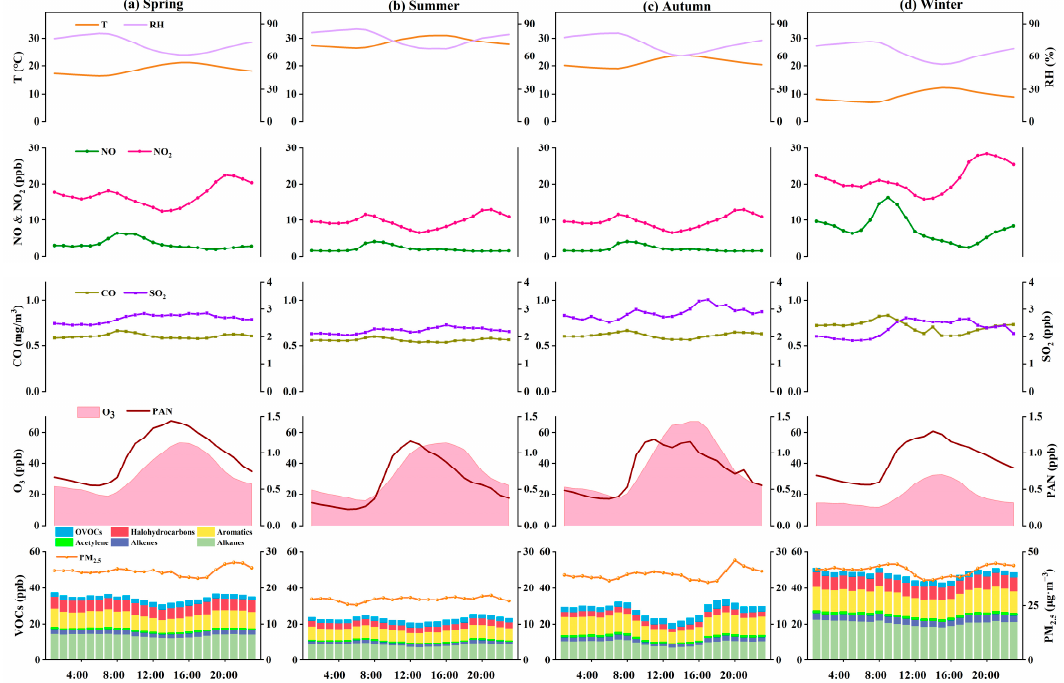
Figure 3. Diurnal trends of O 3 , PAN, VOCs, NO x , CO, SO 2 , PM 2.5 , and meteorological parameters (T and RH) in ( a ) spring, ( b ) summer, ( c ) autumn, and ( d ) winter, respectively. Contrastingly, NO x , CO, and VOCs levels showed a diurnal pattern opposite to O 3 (Figure 3). The diurnal variation of NO 2 exhibited a bimodal distribution, with a peak in the morning, followed by a decrease in NO 2 concentration due to photolysis, and subsequent accumulation of NO 2 at night due to primary emissions. The peak NO x and CO levels in the morning were strongly related to vehicle emissions during the morning rush